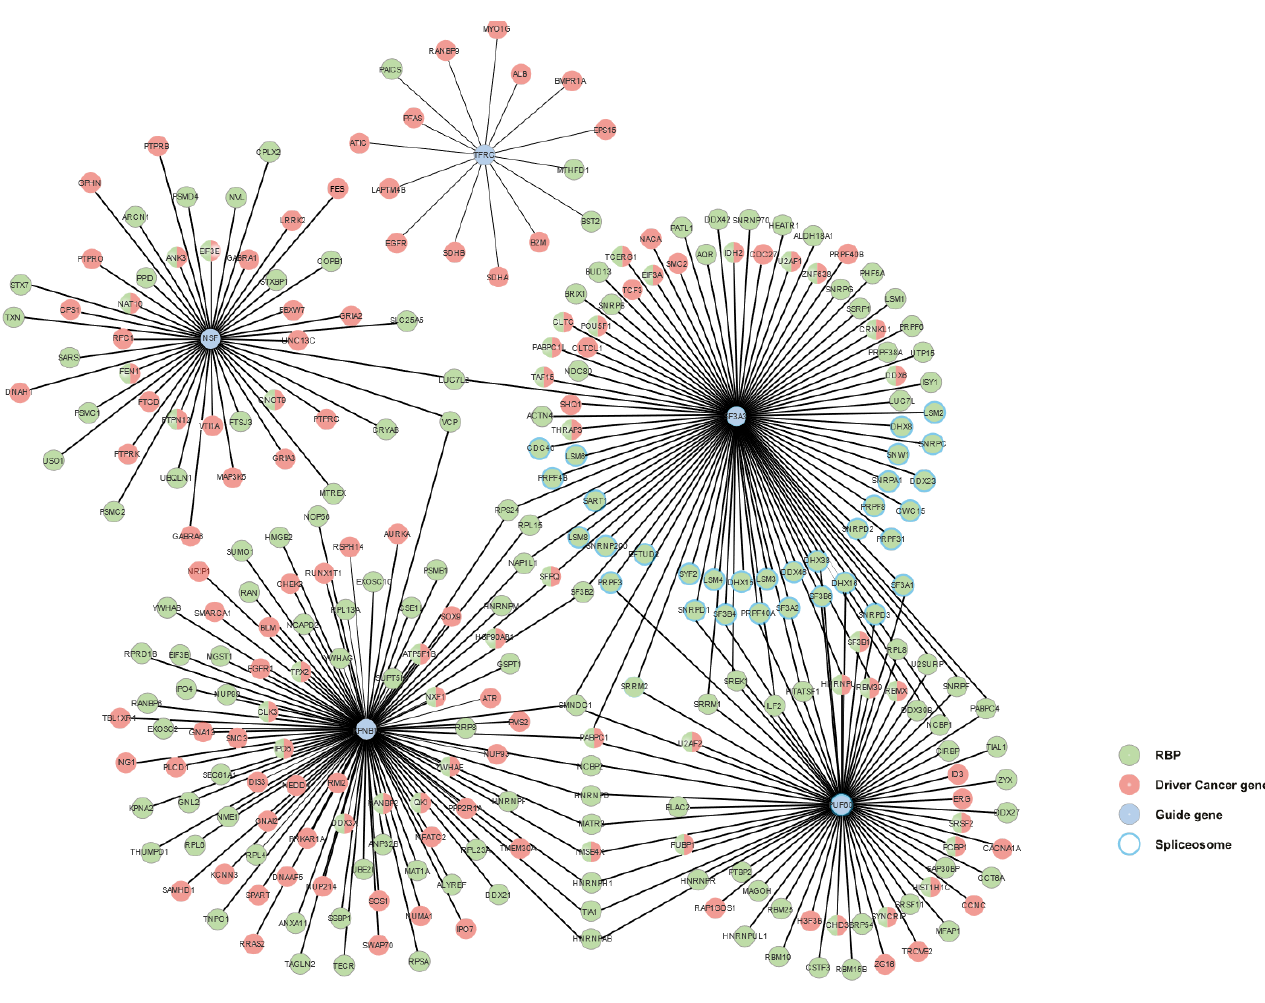
Figure 8. PUF60 and SF3A3 are central elements of a spliceosome-related network involving RNA- binding protein and CDGs. Previously prioritized RBPs (PUF60, TFRC, KPNB1, NSF, and SF3A3) were integrated into a disease gene network (filtered by RBPs and CDGs) using the HumanNet v2 [81,82]. Spliceosome-related proteins and their interactions were determined using MCODE [41] and CORUM [42].